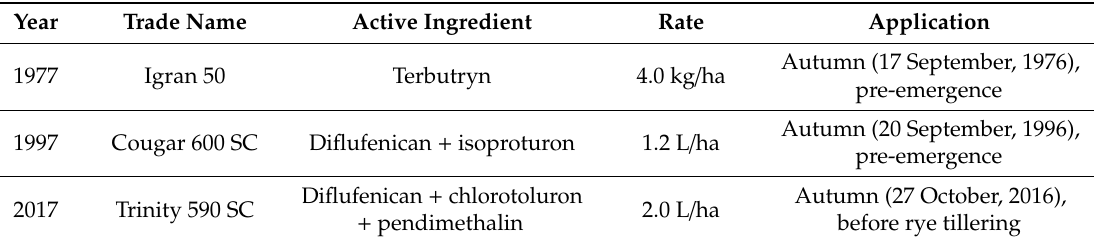
Table 3. Characteristics of herbicides used for winter rye protection in the years under